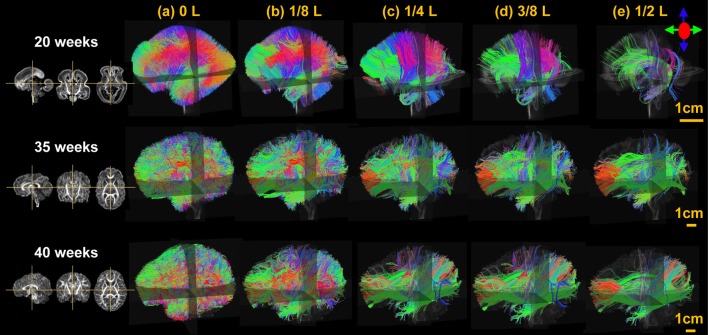
The lateral view of the three-dimensionally reconstructed whole brain fibers filtered at different lengths, namely 0 L (a), 1/8 L (b), 1/4 L (c), 3/8 L (d), and 1/2 L (e) of a typical 20, 35, and 40 PMW brain as shown in the upper, middle, and lower panels, respectively. L is the anterior-posterior length of each brain. On the left, the sagittal, coronal, and axial FA maps of each brain is displayed as anatomical guidance from left to right.